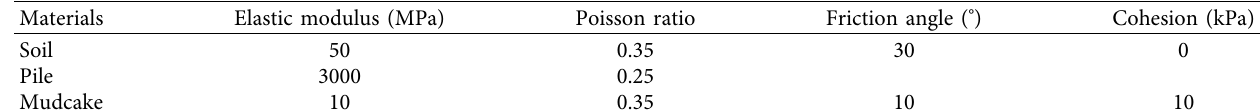
Table 6: Model material parameters.